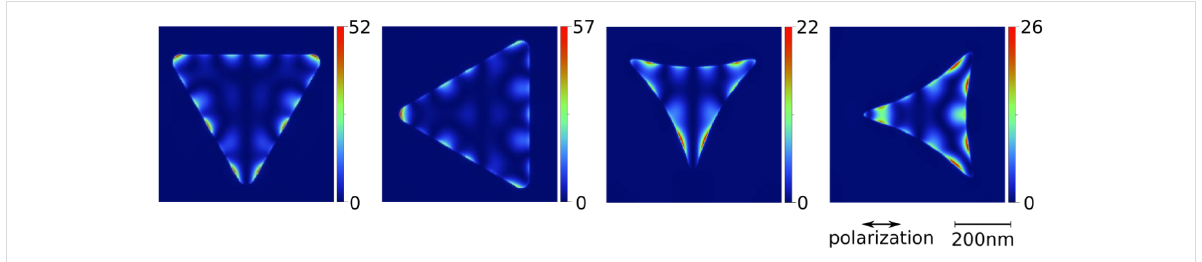
Figure 12: FDTD calculations for the structures presented in Figure 11. The field intensity enhancement was extracted in a plane between the SiO 2 layer (thickness: 2.4 nm) and the Si substrate below the triangle. The simulation volume was 3 × 3 × 6 µm 3 with "perfectly matched layer" boundary conditions. The meshing was set to automatic mode far from the triangle, and a manually refined mesh with a cell size of 2 × 2 × 0.5 nm 3 was added around the particle.